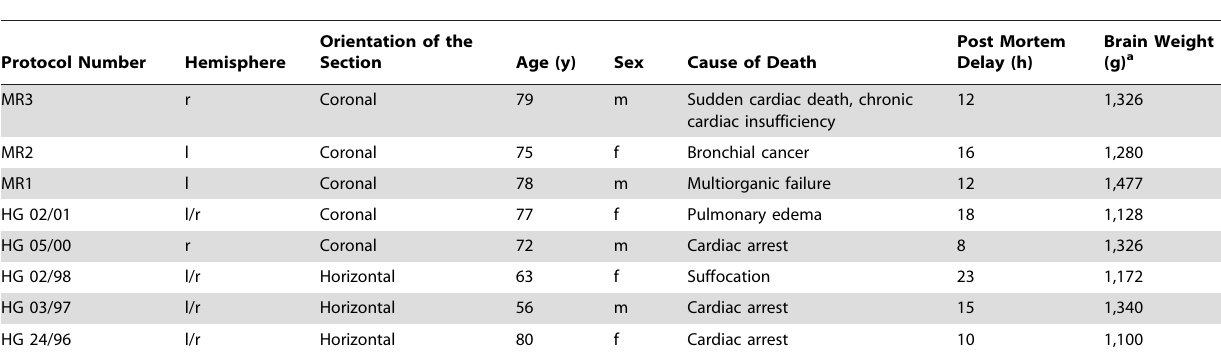
Table 1. Summary of the post mortem